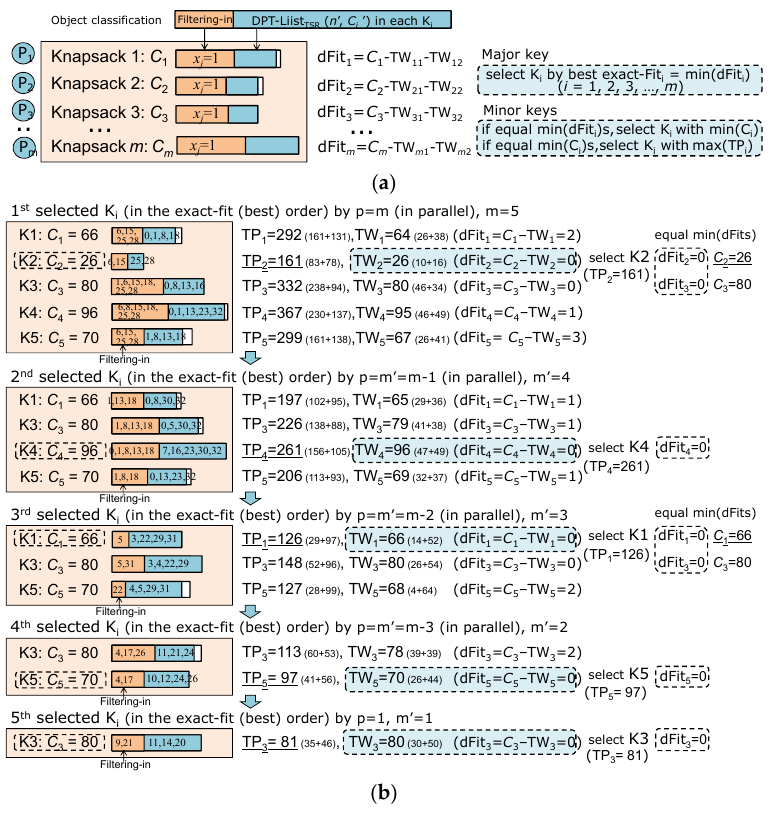
Figure 14. An example of robust unbiased filtering before applying DPT-List TSR on n ’ in K 1 and K 2 .